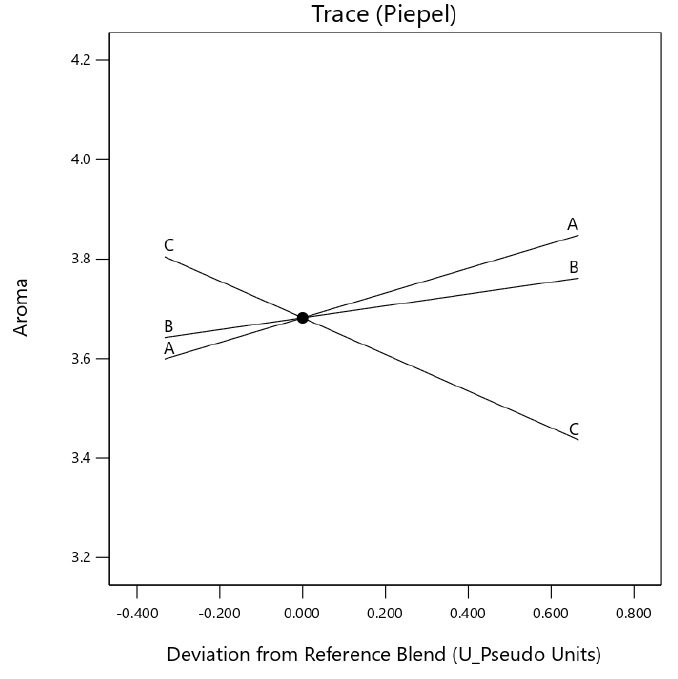
Figure 4. Trace (Piepel) plot for the effect of three components on aroma (A: boiled egusi grit, B: flour and C hydrocolloid) on instant egusi soup.